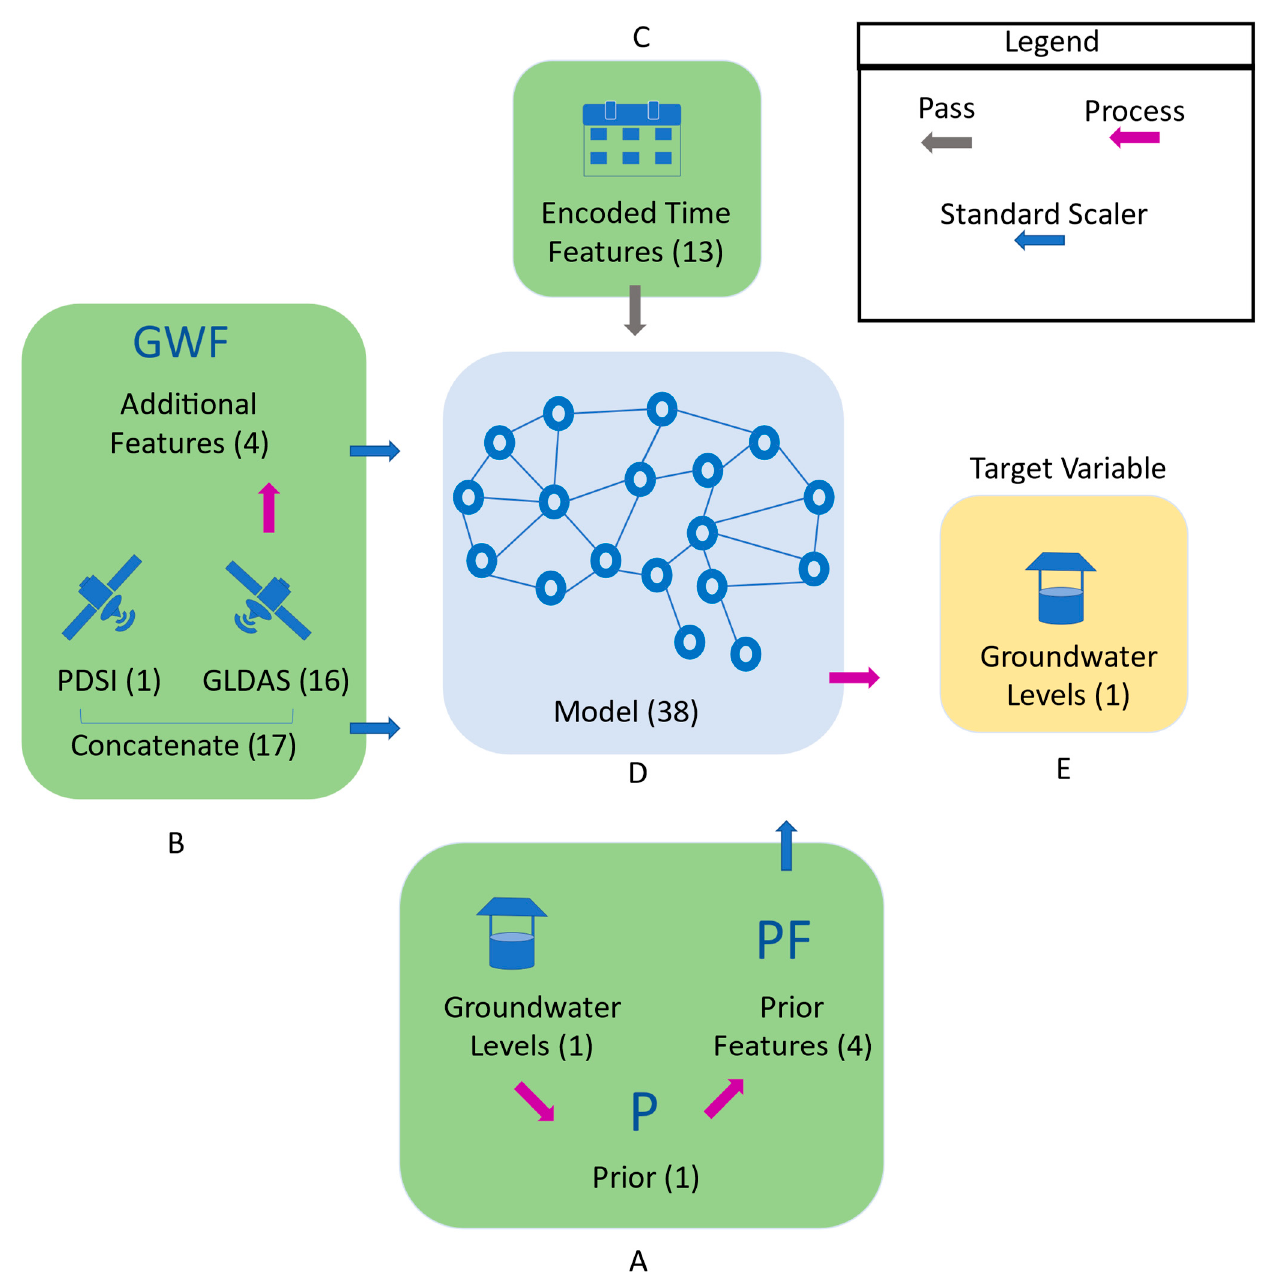
Figure 1. Groundwater imputation workflow describing the datasets and features used in the model which include the groundwater data and prior features ( A ), data from land surface models ( B ), and time features ( C ). These features feed into the model ( D ) and produce the imputed groundwater levels ( E ). The number of features of each type is shown in parentheses.